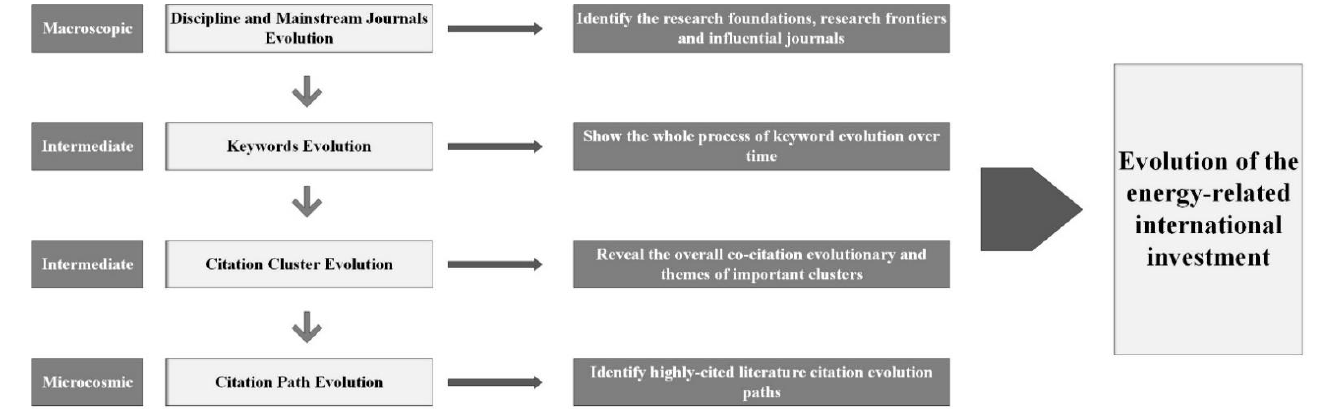
Figure 2. Research framework.